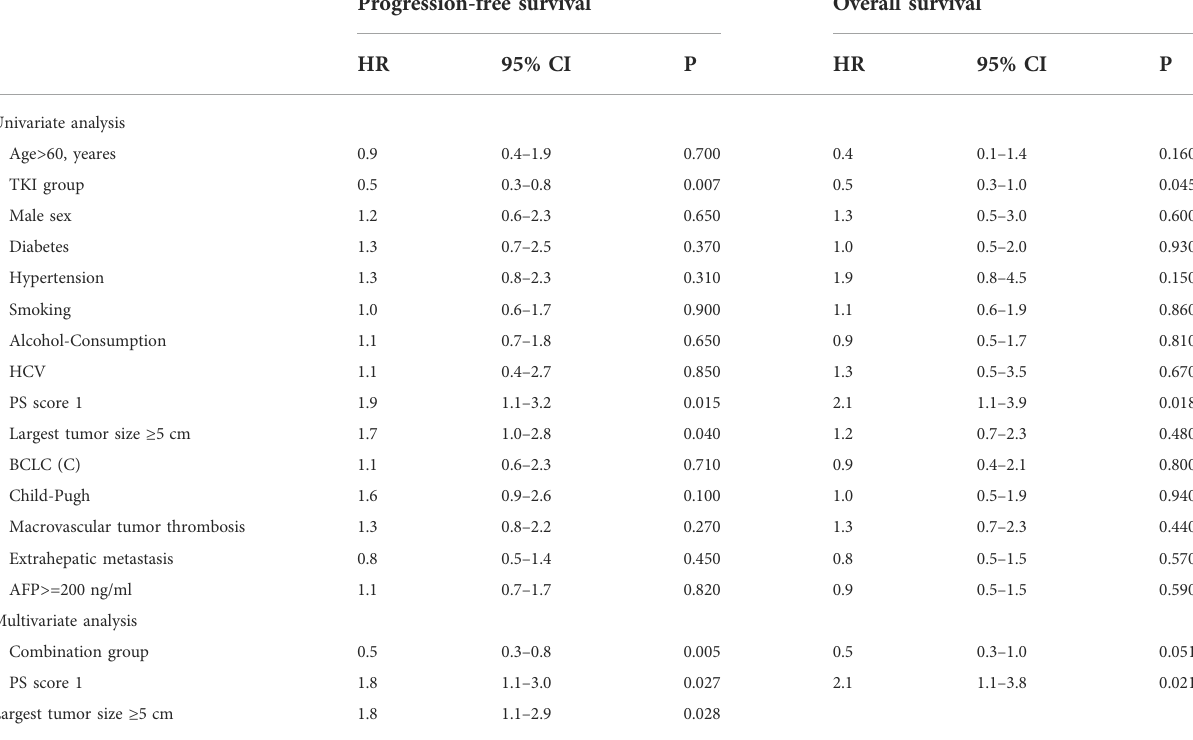
TABLE 3 Analysis of prognostic risk